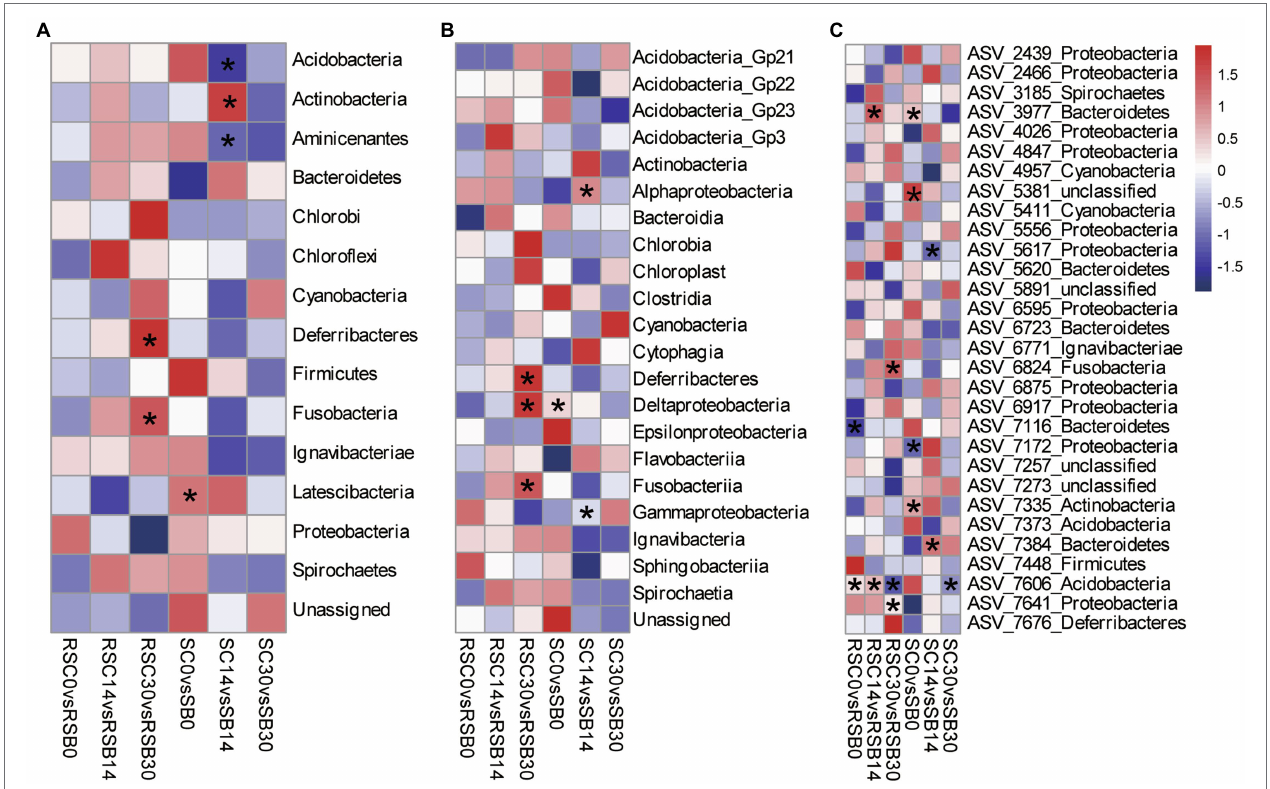
FIGURE 2 | Heatmap of differences between different groups at Phylum (A) , Class (B) and ASV ( C : 30 ASVs with the highest relative abundance) level, respectively. The value represented by the color was calculated by Welch’s t test in STAMP, value >0 (red) means control group has a higher abundance, while value <0 (blue) means biochar addition group has a higher abundance. (* p <